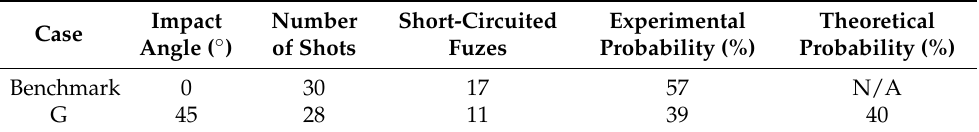
Table 5. Experimental results for the two considered polymer fibre-based net armour configurations and a comparison with the predicted theoretical efficiency for the 45 ◦ impact angle based on the 0 ◦ impact angle